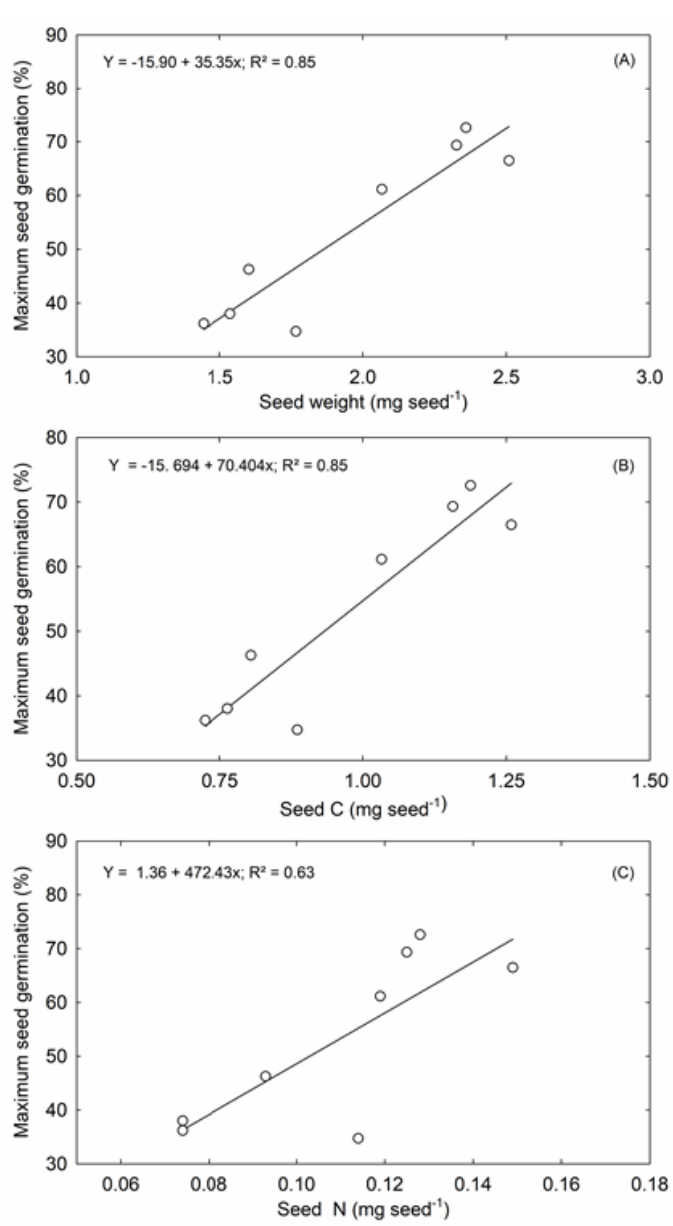
Figure 6. The relationship between maximum seed germination and ( A ) seed weight, ( B ) seed C content, and ( C ) seed N content across eight parental environments. Data are means ± SE of three plants ( n = 3) harvested from a given SPAR unit and used as replicates in statistical analysis for a respective parental environment.